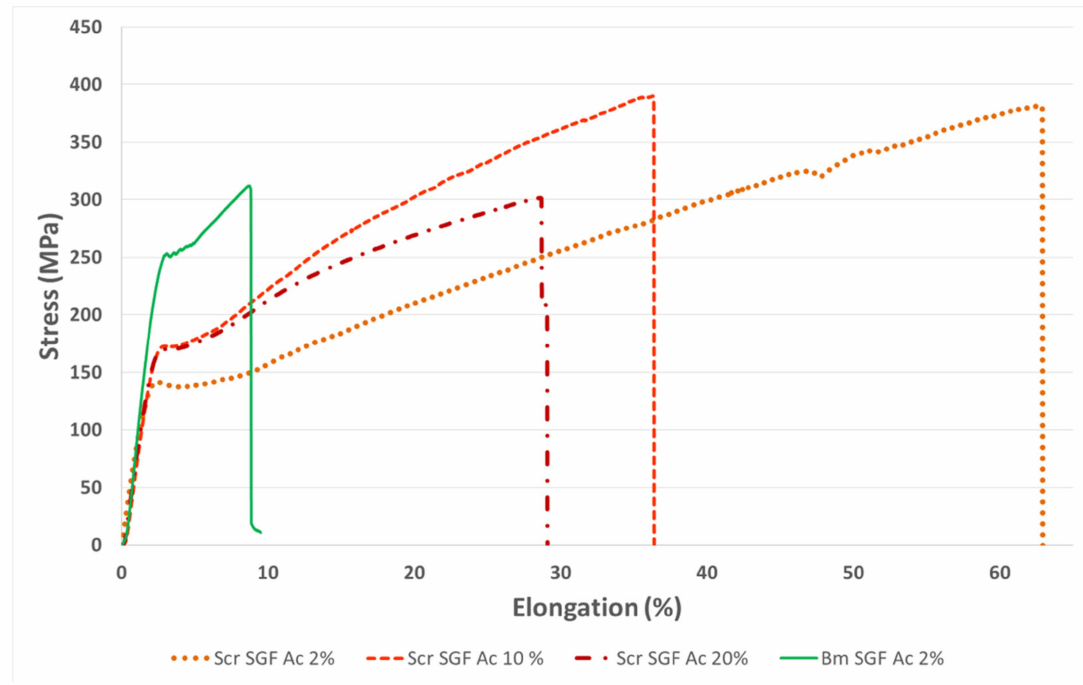
Figure 3. Stress–strain curves obtained during tensile tests of SGFs from silk glands of S. c. ricini (Scr SGF) and from B. mori (Bm SGF). The abbreviations include at the end the concentration of acetic acid dissolution used during its production (2%, 10% or 20% v / v ). Table 4. Values of diameter and mechanical properties of silkworm gut fibres produced from silk glands of S. c. ricini (Scr SGF), under different experimental conditions, and from B. mori (Bm SGF), as described in a previous work [23]. The abbreviations include at the end the concentration of acetic acid dissolution used during its production (2%, 10% or 20% v / v ). Data expressed as average values ± standard deviation. Tensile Strain at Break Elastic Modulus Fibre Diameter Strength (MPa) (%) (GPa) ( µ m) Bm SGF Ac 2% Scr SGF Ac 2% Scr SGF Ac